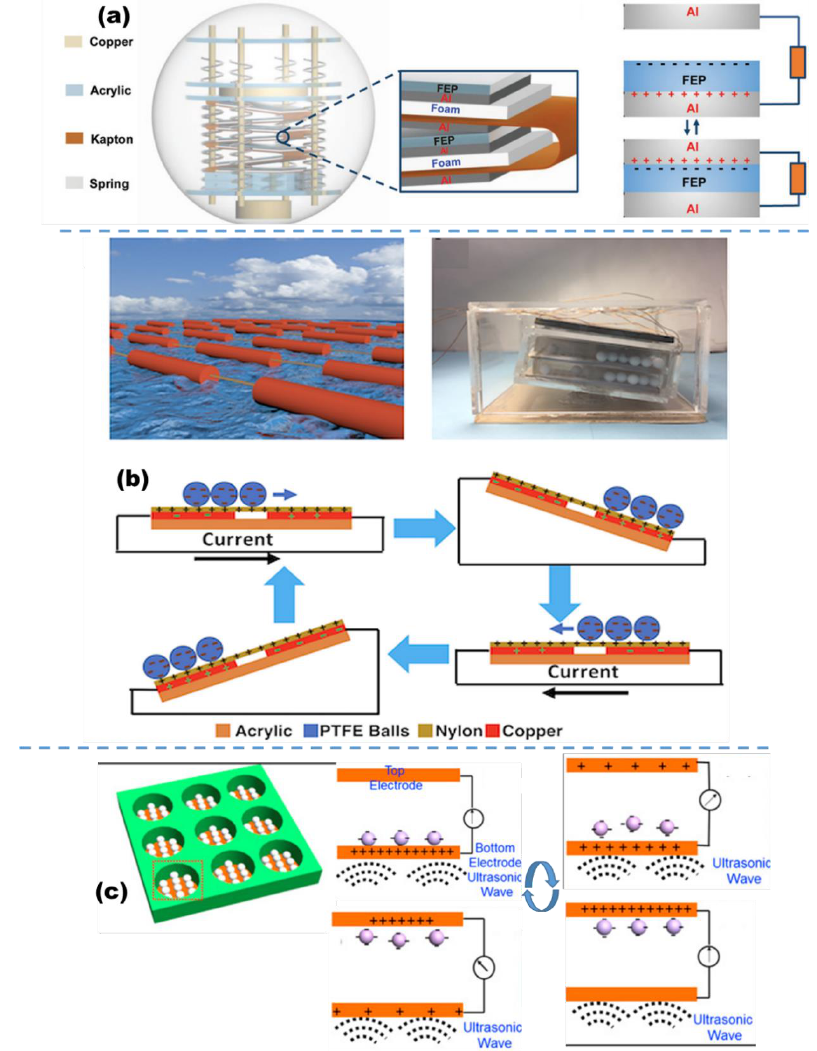
Figure 5. ( a ) A hexagonal TENG network consisting of spherical TENGs units for harvesting water wave energy (reproduced with permission from [131]. Copyright 2019 Elsevier Ltd., Singapore). ( b ) The sea snake- based triboelectric nanogenerator targeted for harvest energy from the wave’s curvature (reproduced with permission from [132]. Copyright 2018 Elsevier Ltd., Singapore). ( c ) TENG targeted for the harvesting of underwater ultrasonic vibrations (reproduced with permission from [133]. Copyright 2017 Elsevier Ltd., Singapore). In another work, a sea snake-based triboelectric nanogenerator (SS-TENG) structure is presented by Zhang [132]. The SS-TENG is the first TENG to harvest energy from the wave ’ s curvature and depends on the advantage of a connected section, which can flex and bend easily as a wave passes through. The SS-TENG is based on a freestanding rolling mode, and the interior is comprised of PTFE balls, nylon film, a sputtered copper layer,